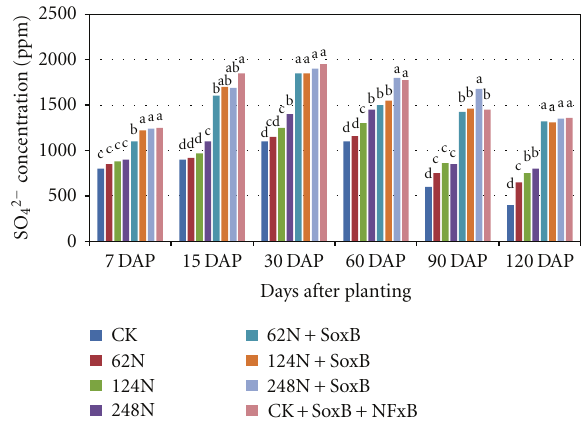
Figure 1: Changes in SO 42 − concentration in onion rhizosphere soil over 120 days after planting (DAP). Means followed by the same letters, by each sampling date, are not significantly di ff erent as per Duncan’s multiple range test at P ≤ 0 . 05.